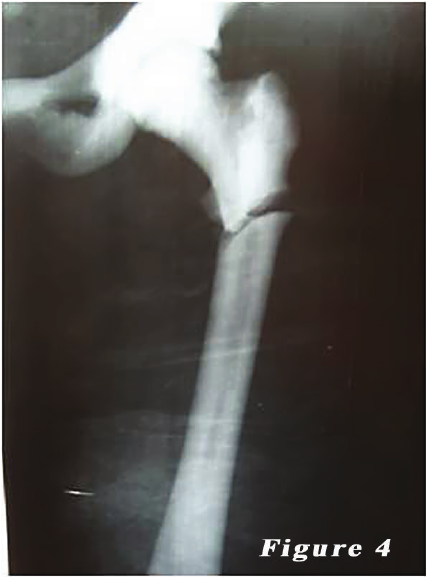
Figure 4: 24-year-old female patient (second case) preoperative radiograph of the left femur subtrochanteric fractures.